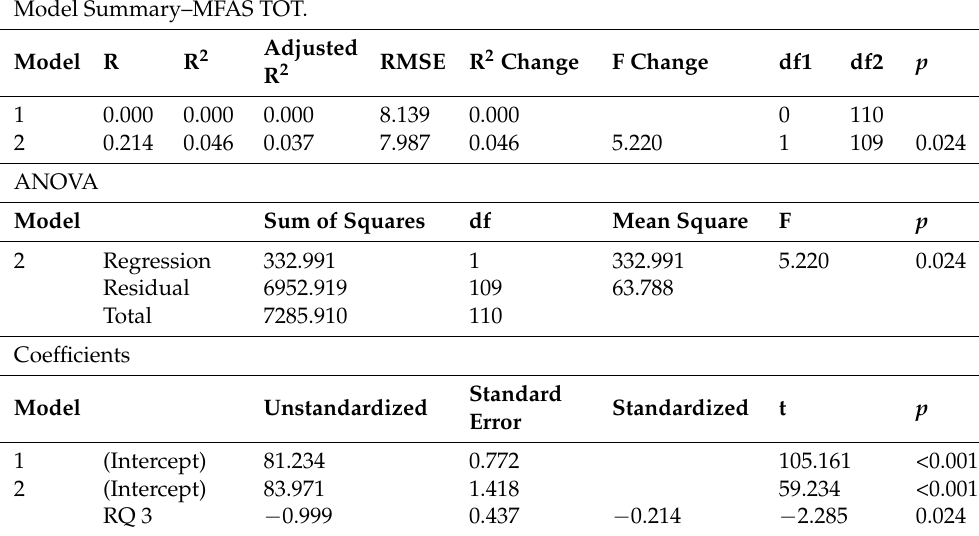
Table 8. Linear regression (MFAS dependent variable). Model Summary–MFAS TOT.